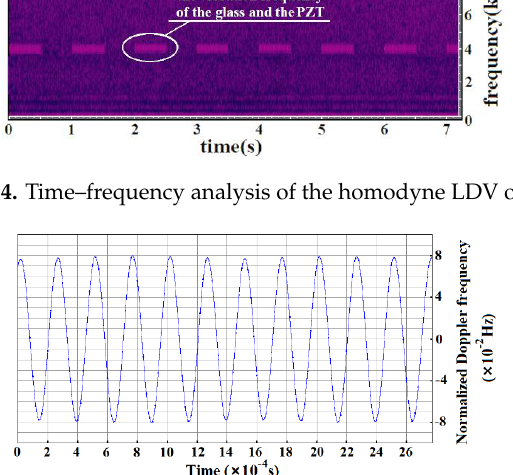
Figure 5. Time-domain waveform of the homodyne LDV output at 4 kHz.